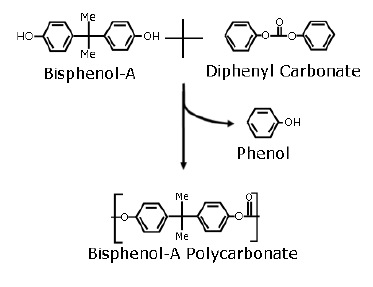
Figure 1. Synthesis of polycarbonate by the transesterification of